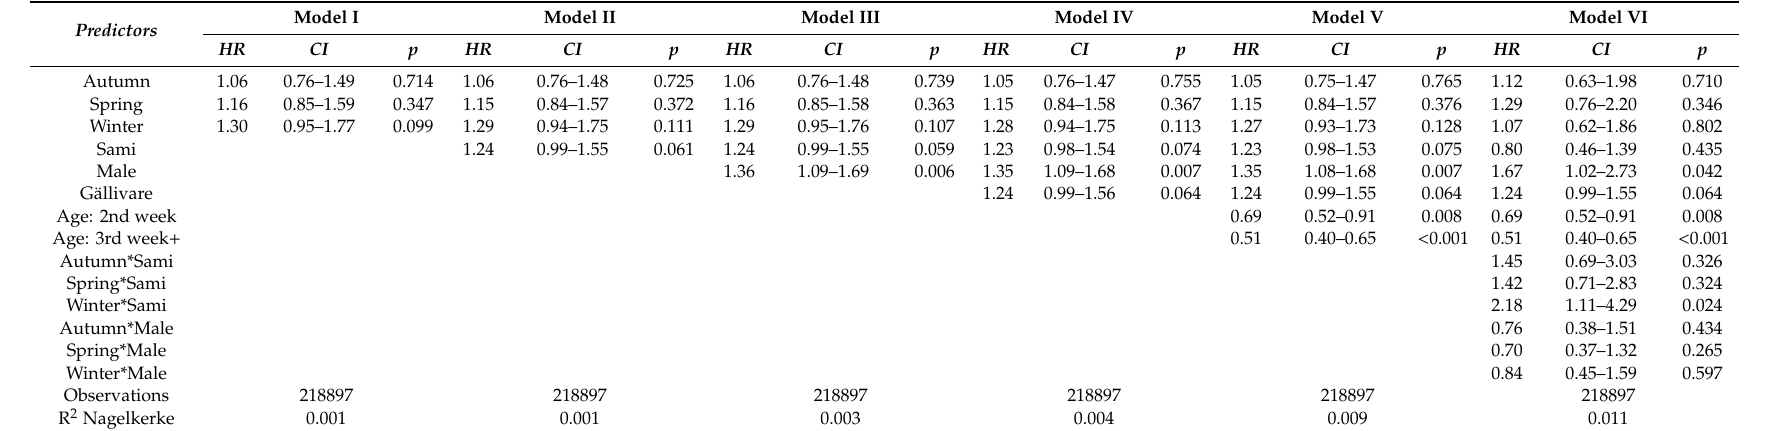
Table A1. Discrete time regression models of neonatal mortality by season, with interactions gender*seasons and ethnicity*seasons, expressed as hazard ratios, confidence intervals (CI 95%) and p -value,